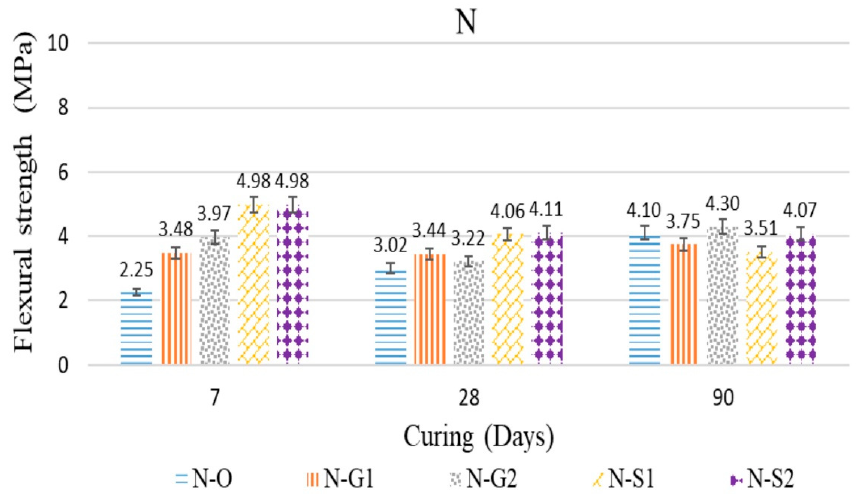
Figure 10. Flexural strength results for ordinary-strength pervious concrete specimens.